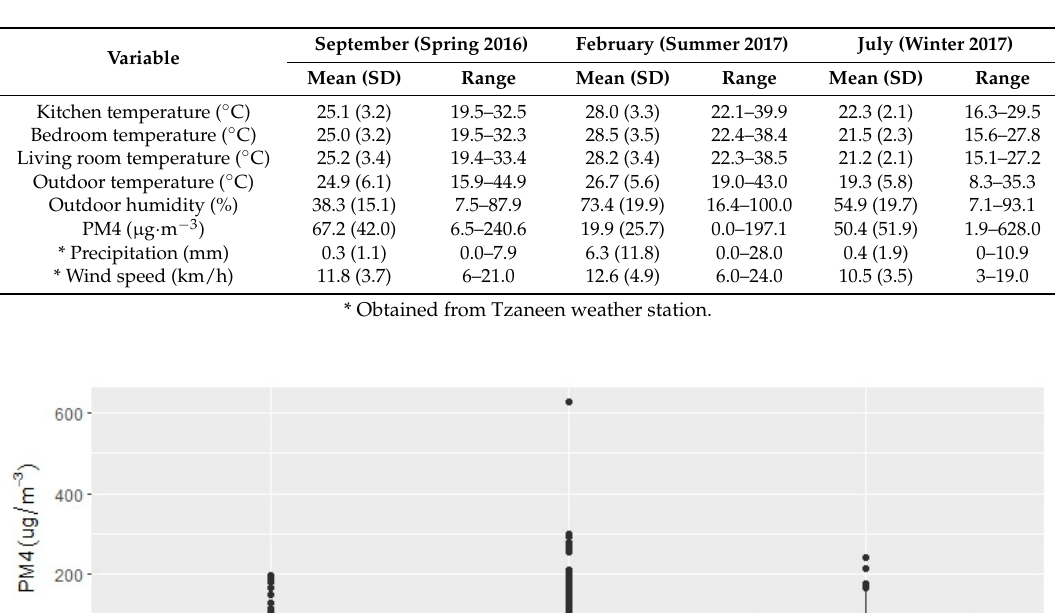
Table 2. Descriptive statistics for indoor air quality and indoor and outdoor meteorological variables.